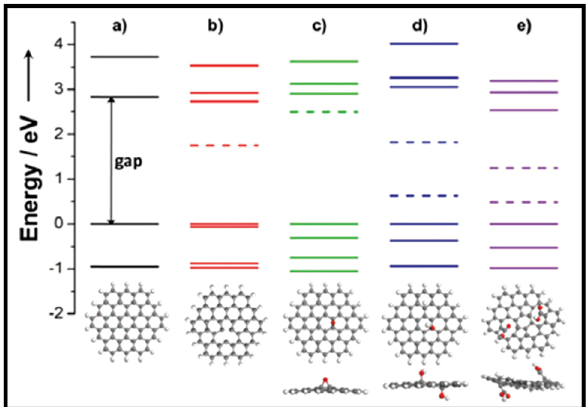
Figure 6: ( a – e ) The energy levels of ideal graphene NSs and deco - rated with various functional groups, such as atomic vacancy, hydroxyl, epoxy, and carboxyl groups [ 90 ] .